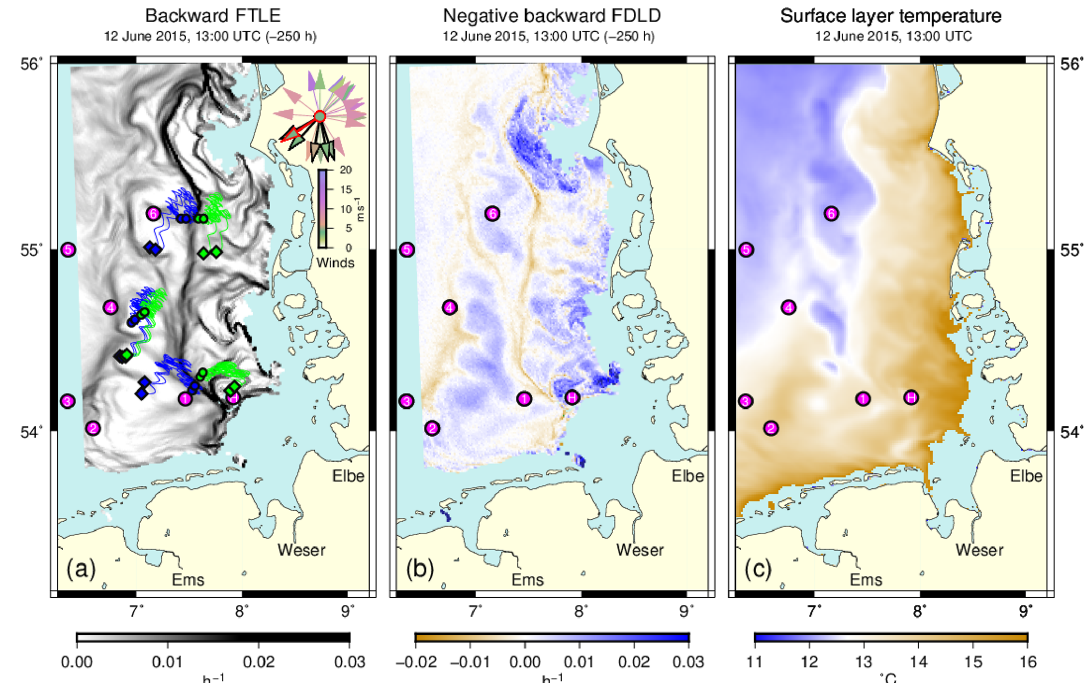
Figure 2. (a) The FTLE field analysed for 12 June 2015 (13:00UTC), evaluating Eq. (5) based on trajectories calculated 250h backward in time. The scale was chosen to adequately visualize ridges of large values. Negative values of the logarithmic FTLE have been plotted as if they were zero. Locations from where trajectories encountered a water depth of less than 5m sometime in the course of their integration were disregarded. Example backward trajectories are shown using different colours (green and blue) for better distinction. Trajectory release points are indicated by circles, and end points are indicated by diamonds. Labelled circles (magenta) indicate the locations of six stations of the MARNET monitoring network (1–6) and of the island of Heligoland (H). Vectors in the top-right corner show past wind directions at 10-hourly intervals, referring to simulations for the location of MARNET station 4. Different wind speeds are represented by different colours. The wind vector at the time of the plot is outlined in red and those during the last 50h are outlined in black. (b) Negative Lagrangian divergences (FDLD) calculated from Eq. (11). The few large positive values, exceeding the range covered by the colour map, are plotted in dark blue. (c) Simulated mean temperatures in the uppermost 5m. To focus on open-sea conditions, temperatures higher than 16 ◦ C are not